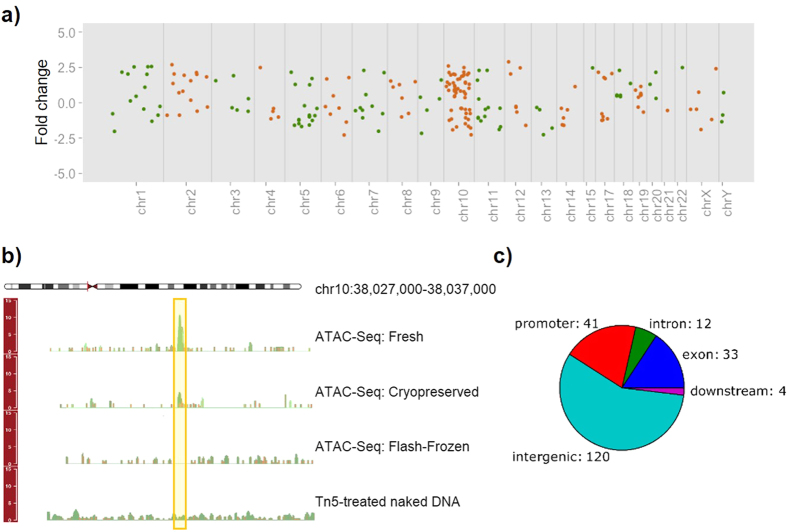
Differentially enriched sites detected between fresh and cryopreserved samples.(A) The fold-change values for differentially enriched sites between fresh and cryopreserved samples are plotted as a function of the position of the sites across all genome. The changes were small (<3-fold). (B) Genomic tracks of ATAC-Seq results showing a differentially enriched site between fresh and cryopreserved samples. (C) Pie chart showing the genomic location distribution of the differentially enriched sites.